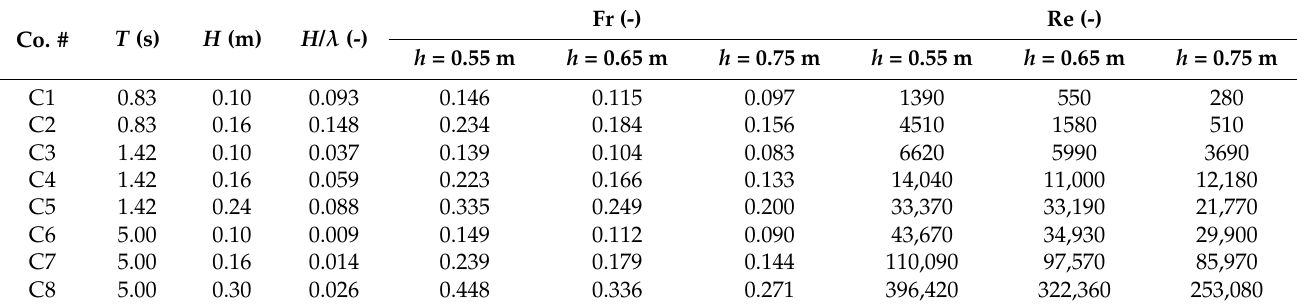
Table 4. Testing conditions for the model in